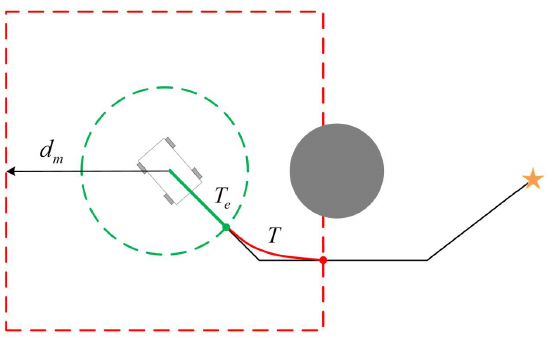
Figure 6. The combination planning strategy for a limited sensing range. The black curve and the red curve are the trajectories before and after the optimization. Circular obstacles are